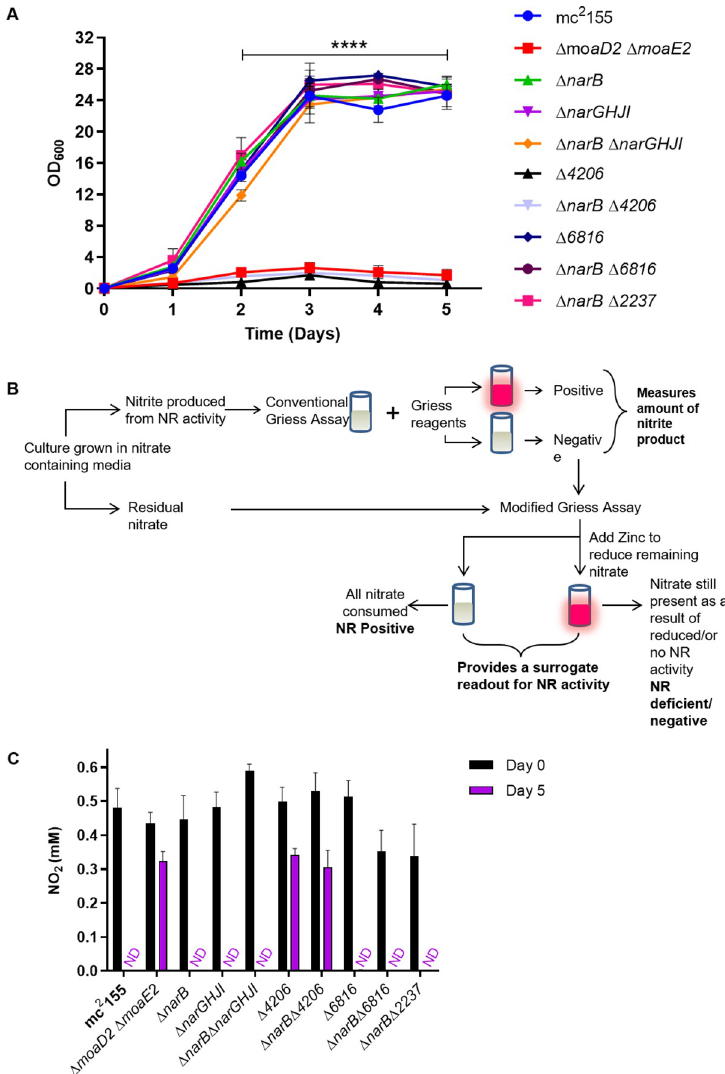
Fig 3. MSMEG_4206 is an assimilatory nitrate reductase. (A) Growth analysis of mutant strains in MPLN with nitrate as the sole nitrogen source. The average of three independent experiments was plotted for each curve and standard errors are depicted. ���� Statistical significance was determined by 2way-ANOVA (B) The conventional Griess assay involves the visualization of samples following the addition of the Griess reagents. A pink colour represents positivity for nitrate reduction, while no colour change is generally considered negative. In the modified Griess assay, a second step is included for samples that had no colour change during the conventional assay. Upon the addition of zinc, a colour change to pink is indicative of no NR activity and the sample is then classified as NR negative. No colour change after the addition of zinc represents complete nitrate utilization and thus NR positivity. (C) The modified Griess assay showed that MSMEG_4206 is required for nitrate utilization during aerobic growth. The average of three independent experiments was plotted for each panel and standard errors are depicted. ND: Not